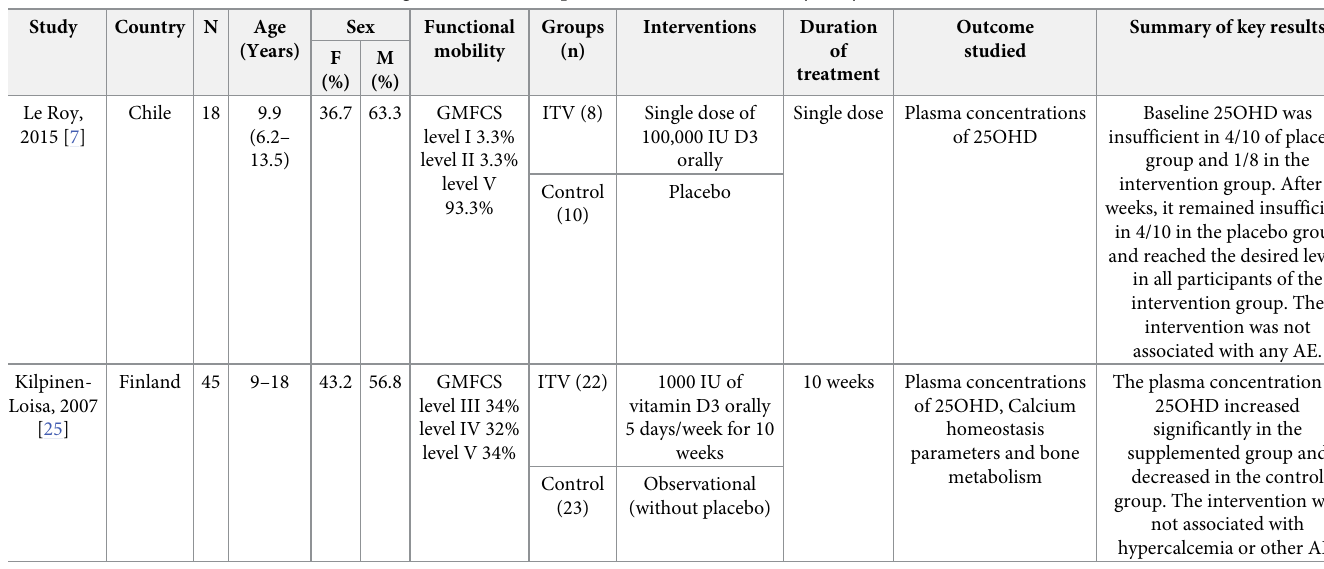
Table 2. Characteristics of the studies evaluating as main outcome plasma concentration of 25-hydroxyvitamin D.